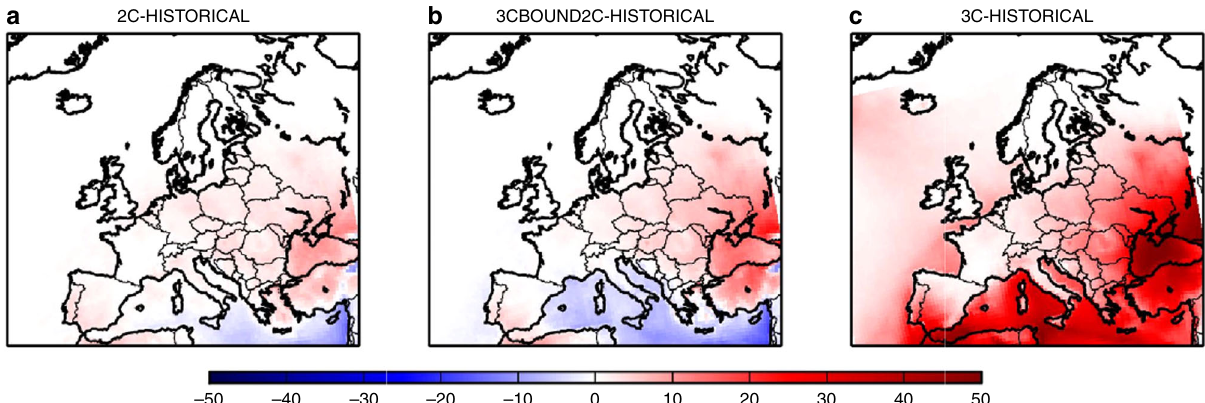
Fig. 3 Differences of annual mean number of days exceeding the WHO threshold. Differences of annual mean number of days where summer daily maximum 8-h average ozone concentrations exceeds 50 ppbv, which is a target value for the World Health Organization, for different scenarios: a 2C minus HISTORICAL, b 3C-BOUND2C minus HISTORICAL, and c 3C minus HISTORICAL. The means are calculated from the 30-year period of the different scenarios. Units are ppbv. The different scenarios are described in Table 1. This fi gure has been generated using the Matplotlib library for the Python programming language (https://matplotlib.org/)